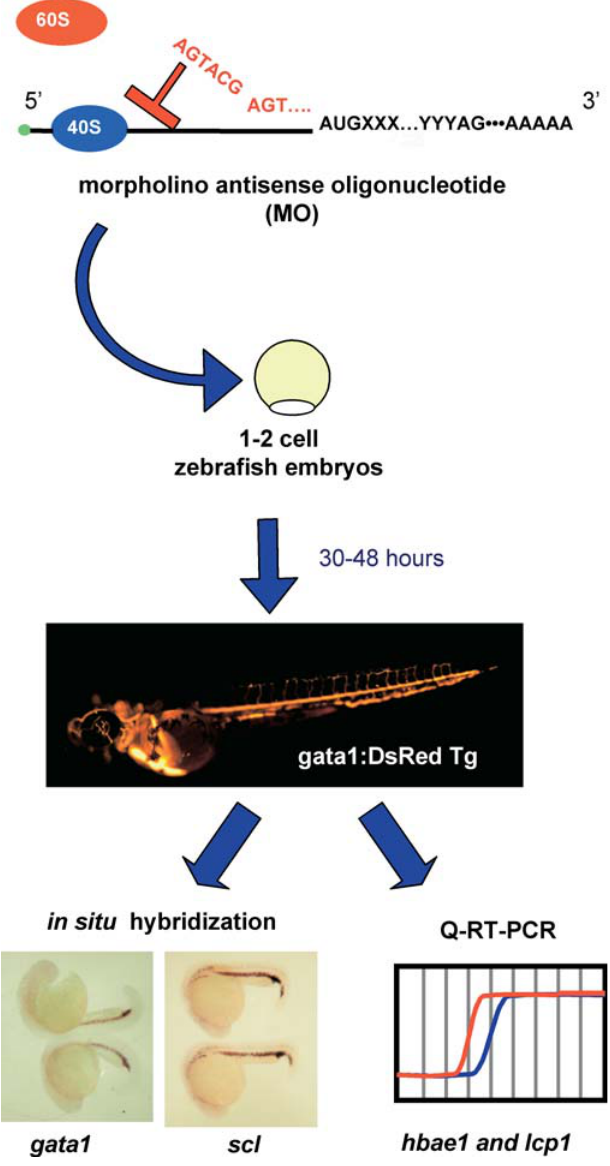
Figure 2. Functional Genomics Screen in Zebrafish The hematopoietic function of differentially expressed candidate genes was determined by injecting MOs into one- to two-cell embryos from gata1: DsRed Tg zebrafish to disrupt gene expression. Injected embryos were scored at 30–48 hpf for the presence of DsRed þ blood cells by fluorescence microscopy. Subsequently, MO-targeted embryos with gross hematopoietic defects were analyzed for the expression of the early hematopoietic markers gata1 and scl by whole-mount in situ hybridization, and the late hematopoietic markers hbae1 and lcp1 by Q- RT-PCR. DOI: